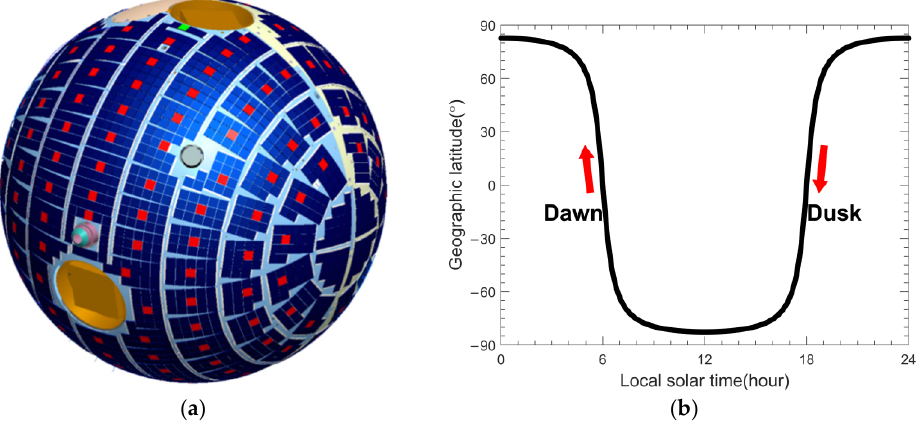
Figure 1. The spherical experimental satellite and its local solar time: ( a ) the spherical experimental satellite; ( b ) local solar time and latitude distribution of the satellite